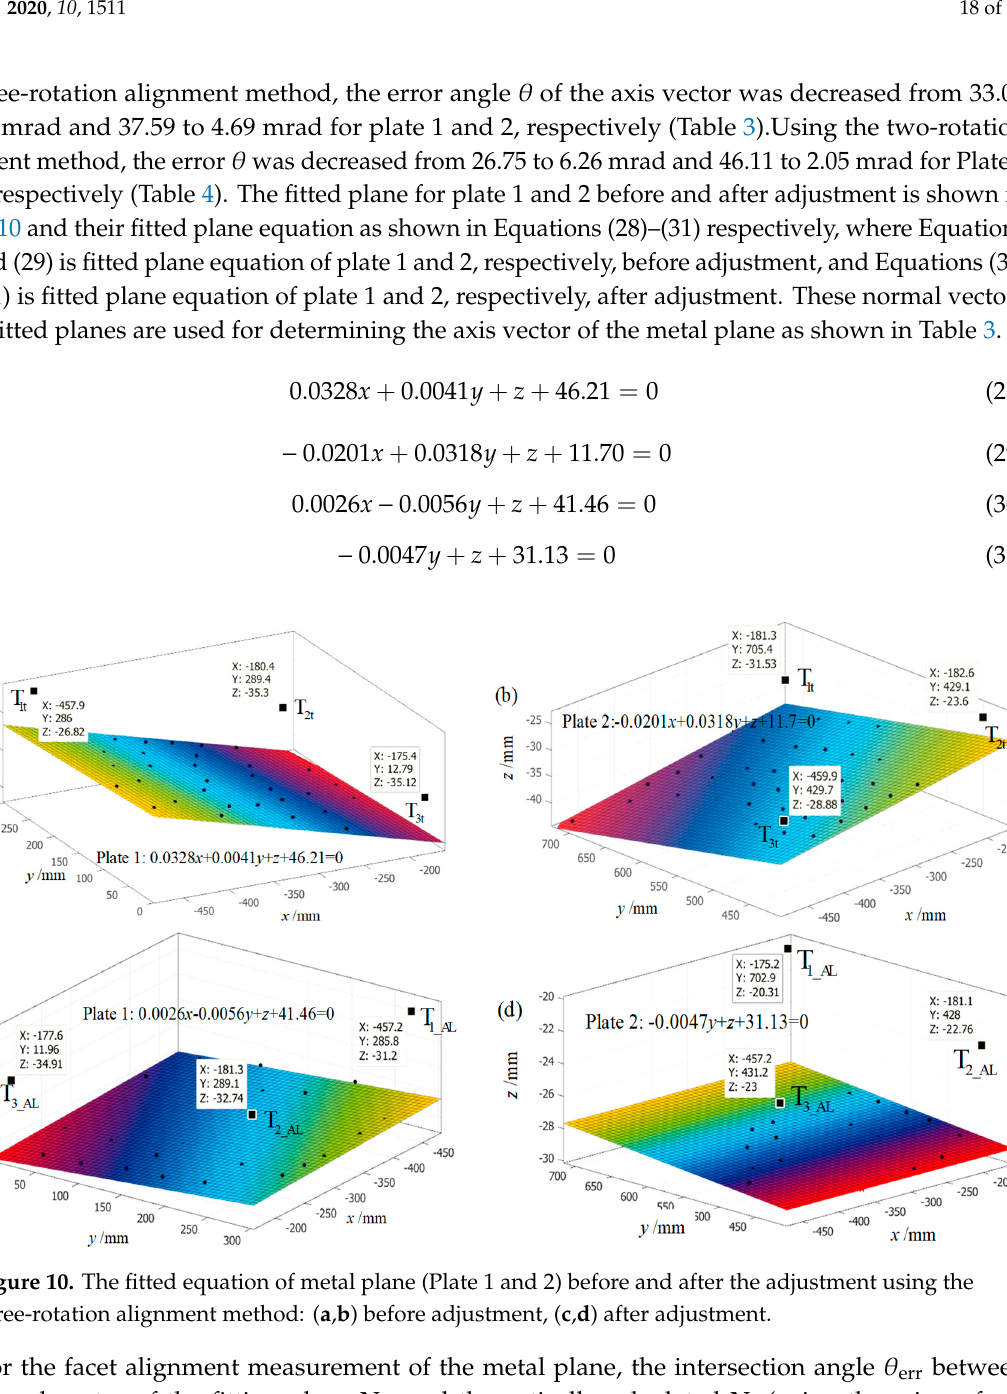
Figure 11. The support distance of bolt 1 before and after alignment in Plate 1 using the three ‐ rotation alignment method: ( a ) before alignment, distance is 18.40 mm and ( b ) after alignment, distance is 10.82 mm.